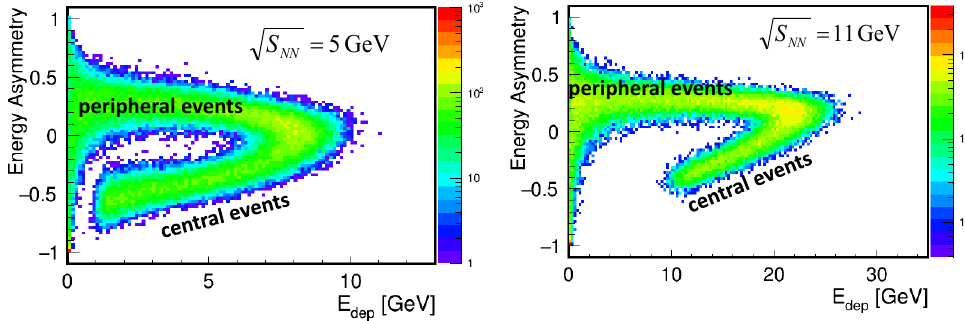
Figure 5. Correlation between the energy asymmetry, A E , and total energy deposition, E dep in FHCal √ s NN = 5 (left) and 11 GeV (right) simulated with the LA-QGSM model for Au + Au collisions at